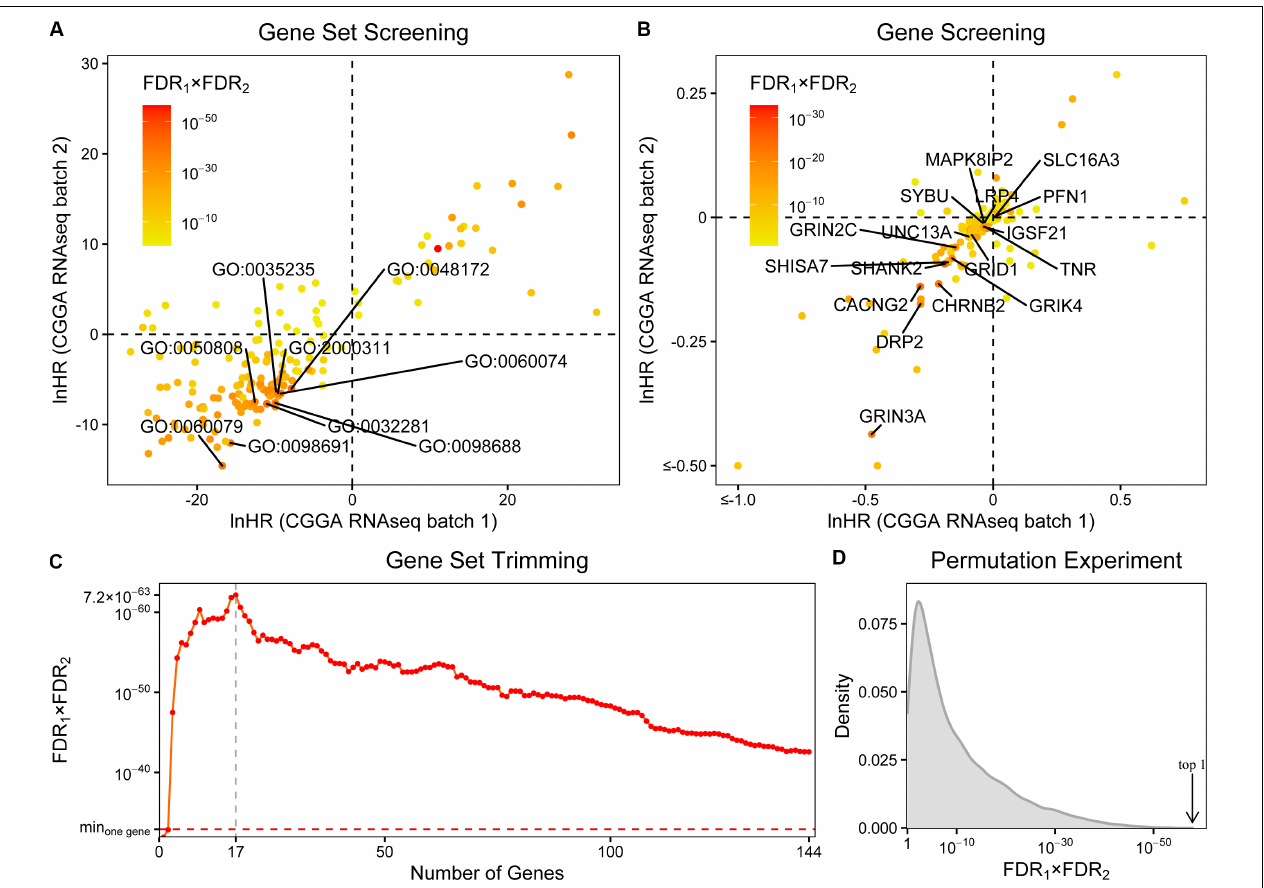
FIGURE 1 | The screening of synapse-related genes. (A) The survival prognostic performances of 163 synapse-related gene ontology terms. The chosen terms were labeled. (B) The prognostic performances of 171 collected genes. The finally selected genes were labeled. (C) The prognostic performances of gene sets with different sizes. Min onegene : the best performance of single collected gene. The prognostic performances were evaluated by hazard ratios (HRs) of Cox regression. FDRs were calculated by Benjamini-Hochberg method. (D) The distribution of combined FDRs of 10,000 random 17-gene sets. Arrow: the combined FDR of our synapse-related 17-gene